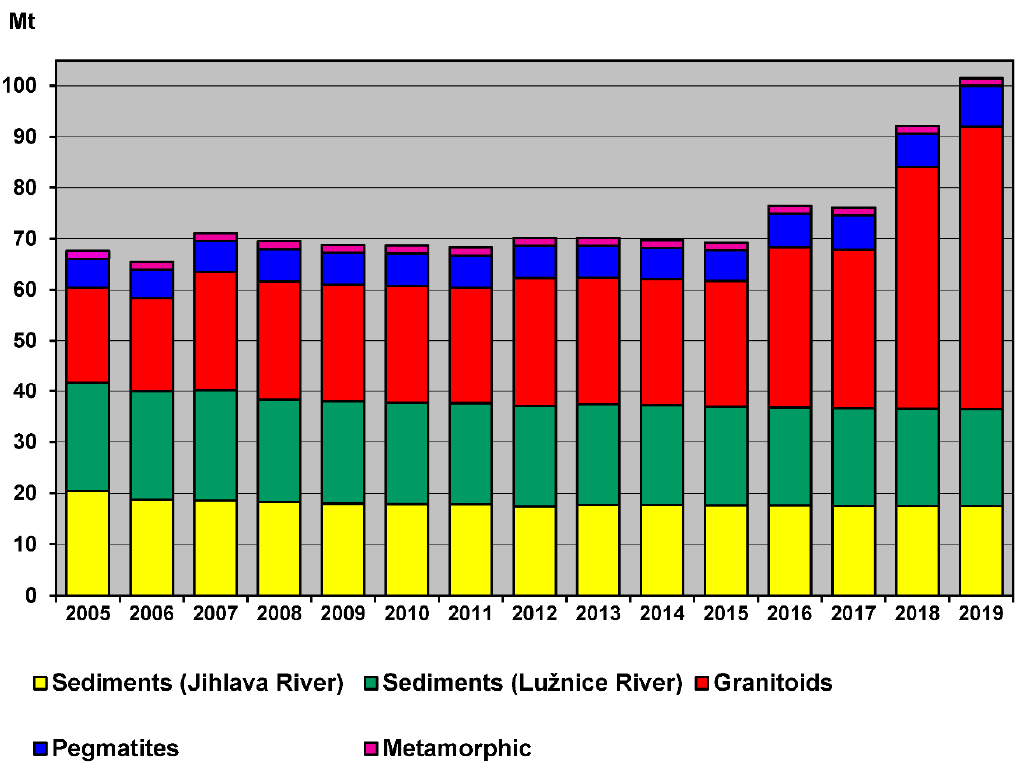
Figure 3. Total resources of the Czech feldspar deposit divided according to their geological types (modified after [36,38–40]).